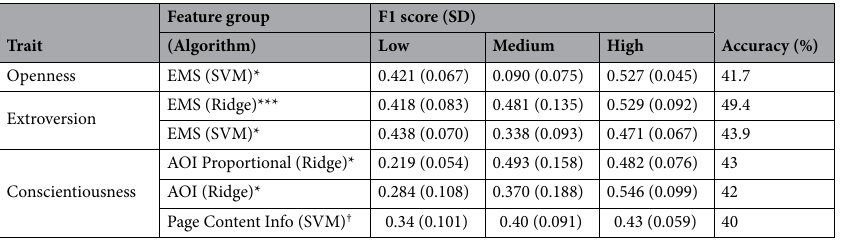
Table 6. Classifier performance by personality category for significant models. *p < 0.05, **p < 0.01, ***p < 0.001 corrected via Benjamini–Hochberg procedure. † Included for comparison, Ridge One-vs-Rest Ridge Classification, KNN K-nearest neighbors, SVM Linear support vector machine, AOI Area of Interest, EMS Eye Movement